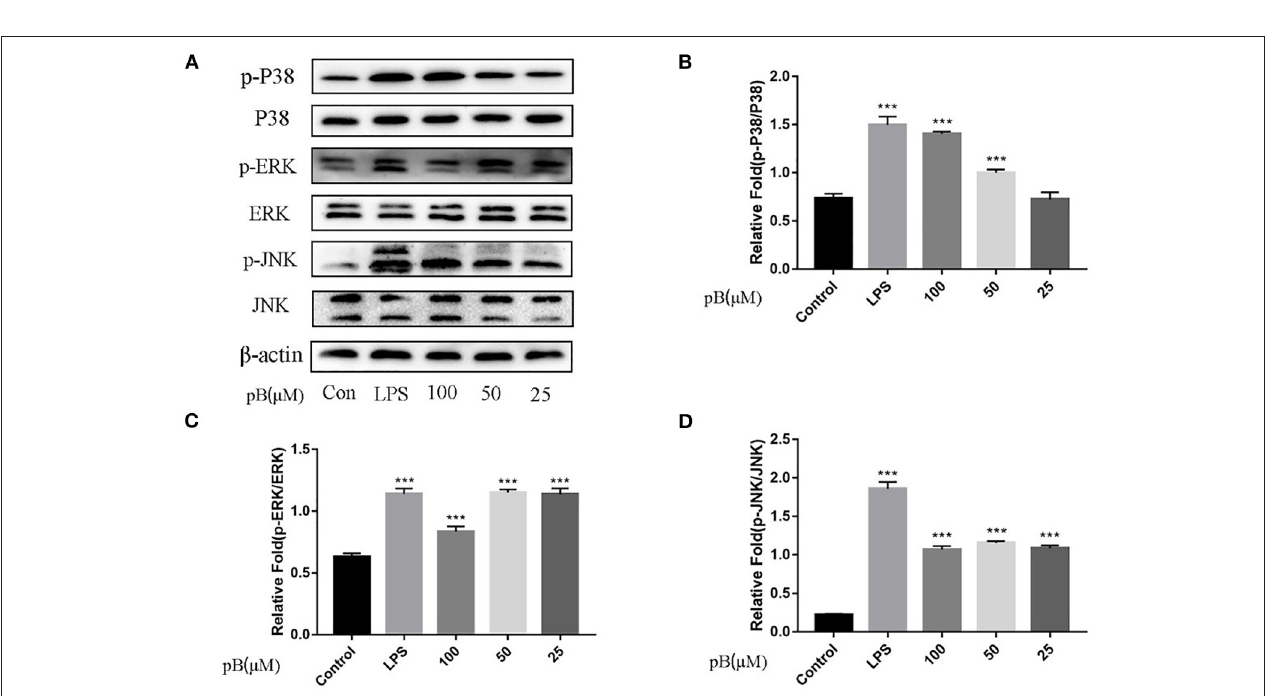
FIGURE 6 | Effects of pB on the mitogen-activated protein kinases (MAPKs) pathway with Western blotting. (A) The expression of p-P38, P38, p-ERK, ERK, p-JNK, and JNK detected using Western blotting. (B) The ratio of the content of p-P38/P38. (C) The ratio of the content of p-ERK/ERK. (D) The ratio of the content of p-JNK/JNK. Data presented are the mean ± SD, n = 3. Compared with the control, *** p < 0.001.